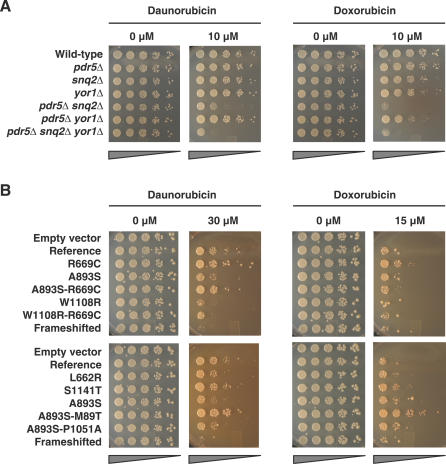
Functional Complementation of Human cDNAs for P-Gp Variants in a Drug-Sensitive Yeast Strain(A) Differences in drug sensitivity of yeast strains. Yeast strains tested included mutants in which combinations of three major endogenous multidrug transporter genes, PDR5, SNQ2, and YOR1, were deleted. Cultures from each strain were adjusted to the same cell concentration and serially diluted 5-fold. The genotypes of the strains tested are shown in Table S1. The pdr5 snq2 yor1 triple mutant was consistently the most sensitive strain to daunorubicin and doxorubicin.(B) Restoration of drug resistance in the hyper-sensitized yeast strain by P-gp variants. Cultures from each strain were adjusted to the same cell concentration and serially diluted 5-fold. Variants restored drug resistance of the hyper-sensitized yeast strain to varying degrees. The strains tested are pdr5 snq2 yor1 with plasmids carrying the indicated variants (Table S1). A frame-shifted P-gp was used as a negative control.